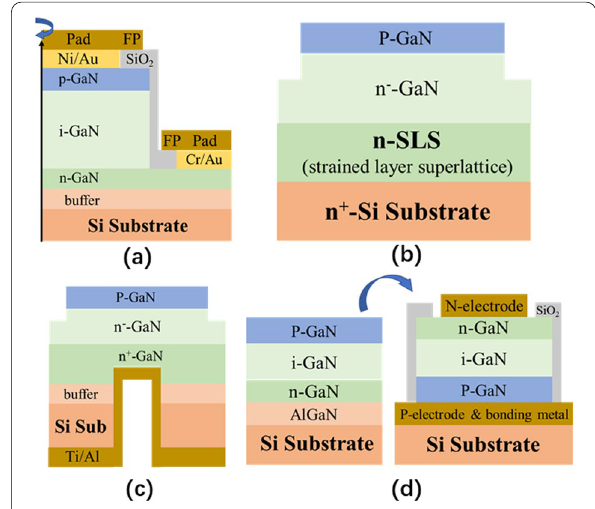
Fig. 10 a Quasi‑vertical PINDs with FP; b fully vertical PNDs by using the thin AlN and SLS superlattice structure on conductive Si substrate; c PNDs with trenched ohmic contact on back; d PNDs fabricated by layer transfer technology